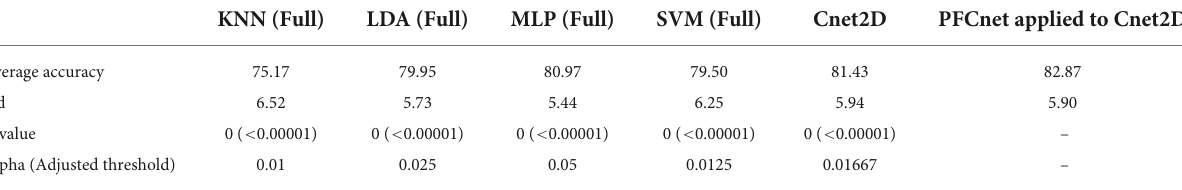
TABLE 4 Comparison between classical classifiers, deep network, and proposed transfer learning method, when the whole training dataset is used for training for Ninapro DB2 dataset ( N = 40) with 17 movement classes (chance accuracy level = 5.88%). KNN (Full) LDA (Full) MLP (Full) SVM (Full)